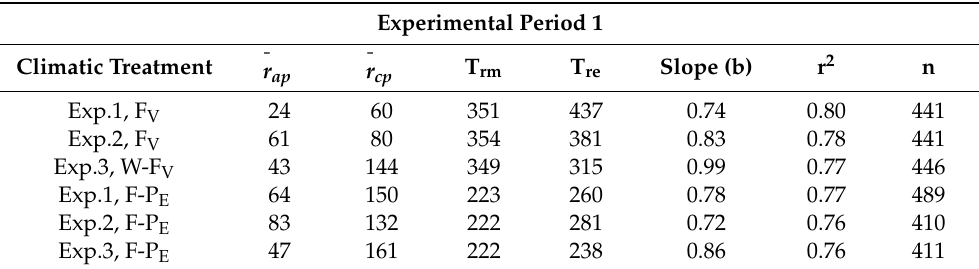
Table 4. Linear regression coe ffi cient of determination (r 2 ), between transpiration estimated by the Penman–Monteith model based on calculated aerodynamic and canopy resistances and values measured with lysimeters for a 10-day period during daylight